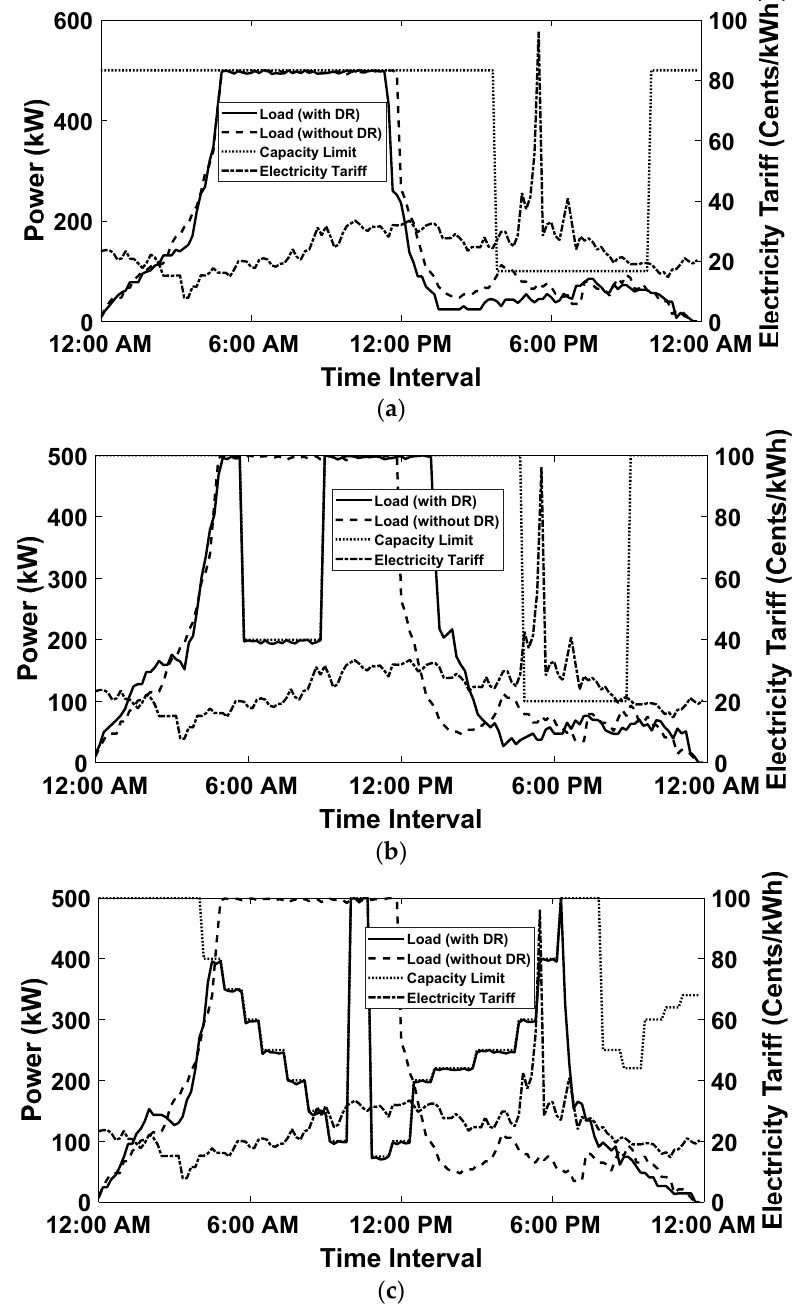
Figure 6. Electric Load Profiles of Smart parking lot with and out DR events. ( a ) Single Constant Load Shedding DR Event (DR1), ( b ) Two Constant Load Shedding DR Event (DR2), ( c ) Variable Load Shedding DR Event (DR3).